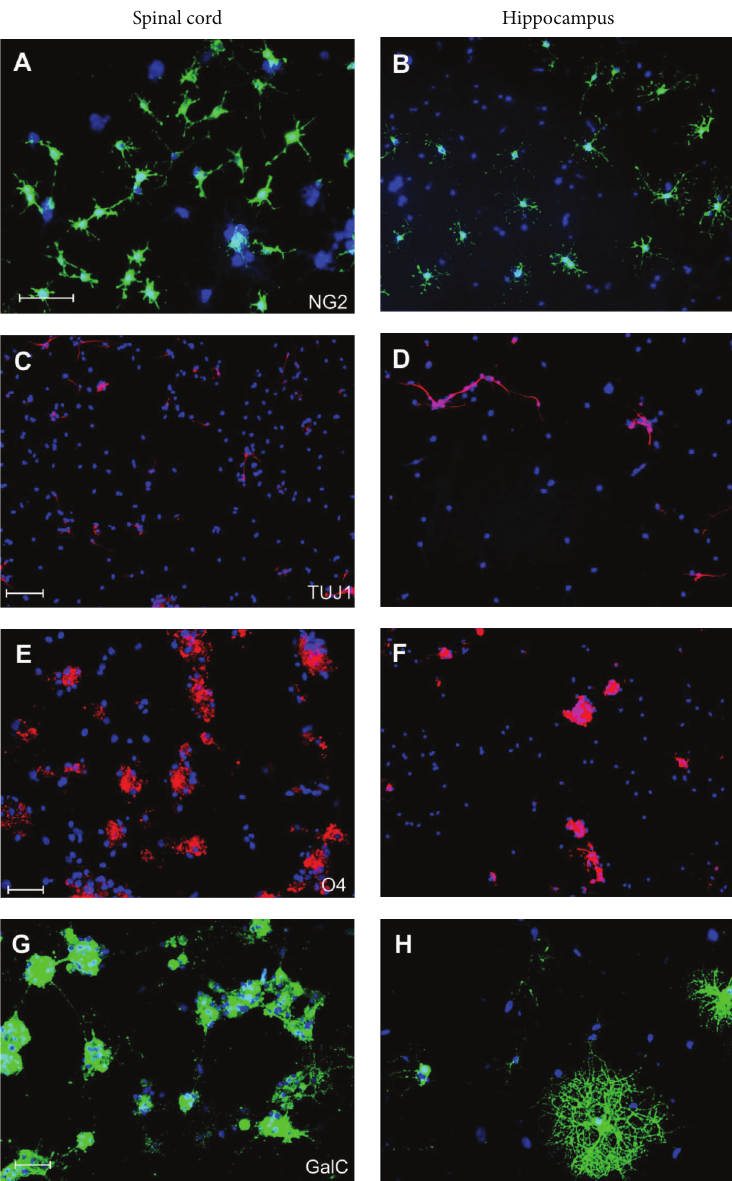
Figure 6: Local tissue (spinal cord versus hippocampus) significantly influences cell commitment, differentiation, and maturation, as observed during 7-day-long coculture experiments. The vicinity of hippocampal slices (right panel) promotes neuronal commitment and maturation (TUJ1) (D) and accelerates oligodendroglial differentiation into cells characterized by complex, multibranched morphology (GalC) (H). Conversely, in medium conditioned by the spinal cords slices (left panel), the progenitor and immature forms of oligodendrocytes are most abundant (NG2, O4) ((A), (E)), while GalC-positive cells begin to send out cell processes (G). Cell nuclei (blue) were stained with Hoechst 33258. Scale bar = 50 𝜇